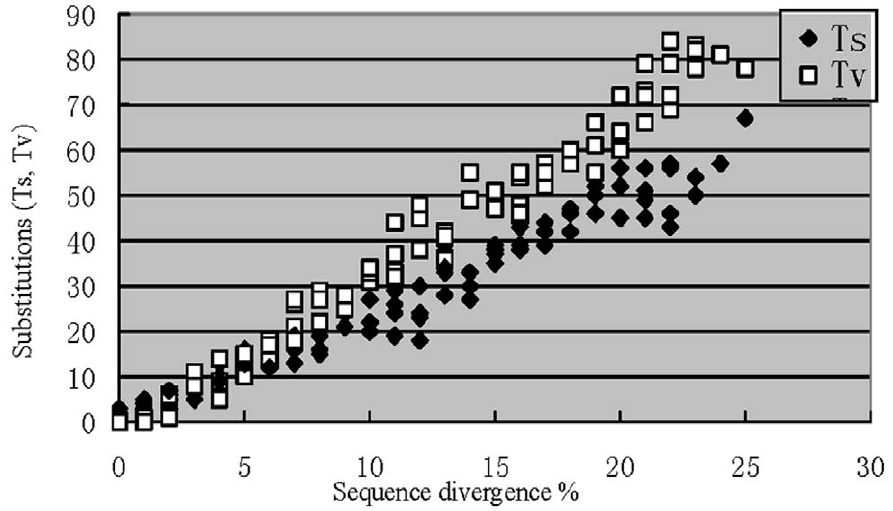
Figure 5. The numbers of COI transitions (ts) and transversions (tv) plotted against sequence divergence.